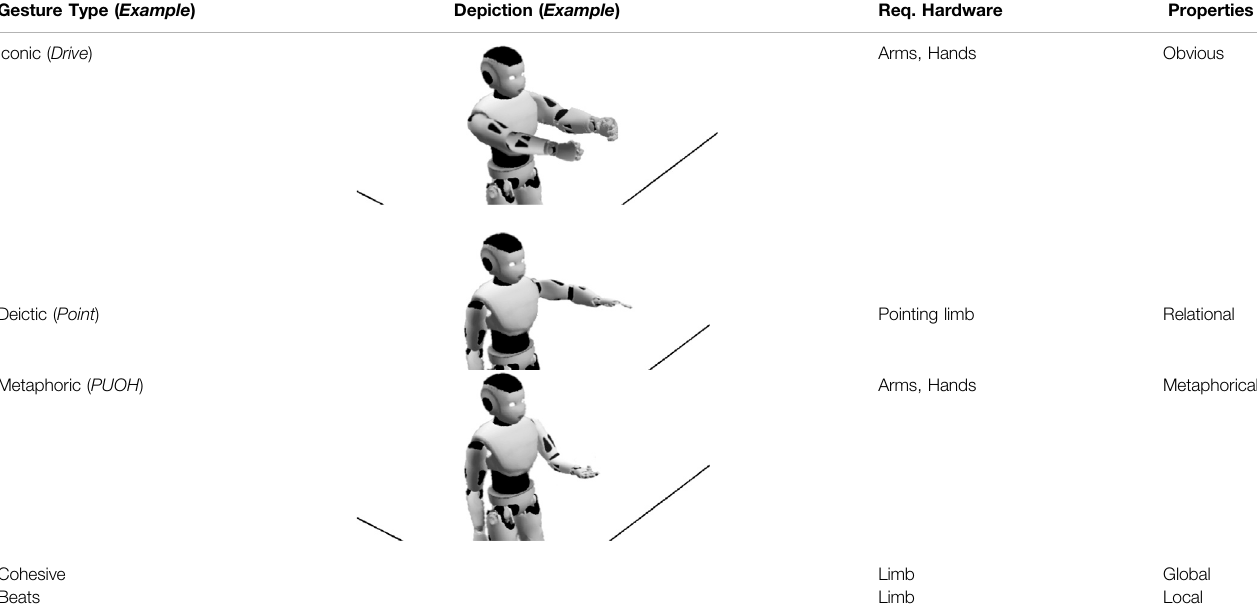
TABLE 2 | Examples of gestures: Iconic , Deictic , Metaphoric , Cohesive and Beats by a robot. Each gesture is ascribed a general property, along with its hardware requirements. Gesture Type ( Example